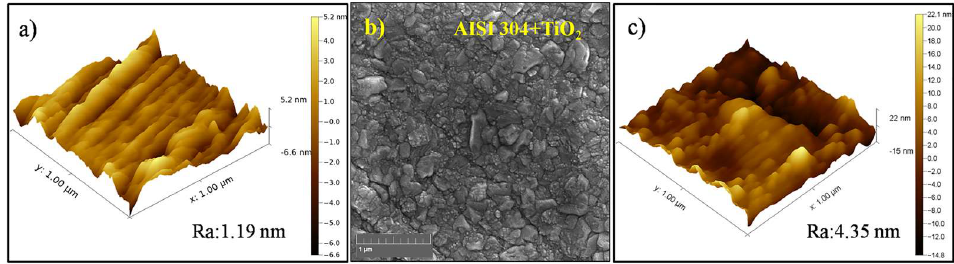
Figure 1. ( a ) AFM image of the AISI 304 surface before film deposition. ( b ) FEG-SEM image of the TiO 2 thin film deposited on AISI 304 (magnification of 80k × ). ( c ) AFM image of the TiO 2 film